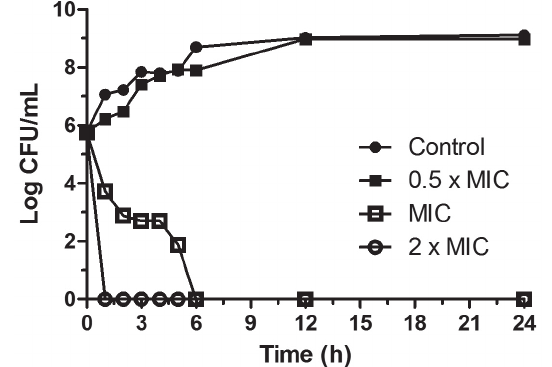
FIGURE 1 - Time-kill curve assay of carvacrol at 0.5 x MIC (156 µg mL -1 ), MIC (312 µg mL -1 ) and 2 x MIC (624 µg mL -1 ), against planktonic cells of Salmonella Typhimurium ATCC